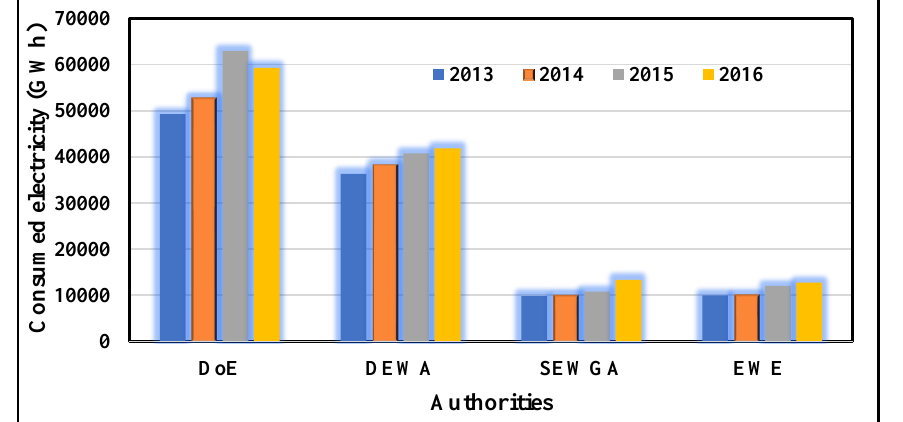
Figure 13. Consumed electricity (GWh) by authority [81].